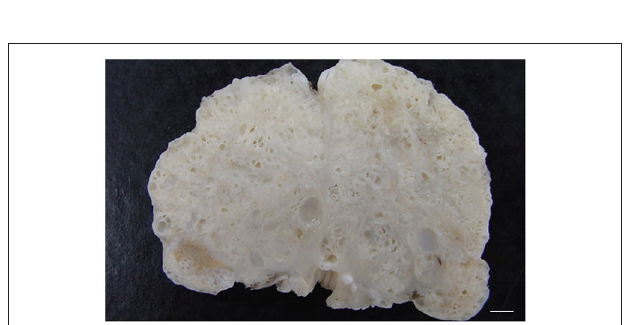
FIGURE 4 | Prostate aspirate showing a large cluster of uniform prostatic epithelial cells from a dog with prostatic hyperplasia. The cells have moderate amount of granular cytoplasm and round, central to eccentric nucleus with finely stippled to reticular chromatin. Note the pink granular material on the background, most likely indicating the secretory proteinaceous activity of the glandular epithelial cells. Prostate FNA, cytospin. Wright-Giemsa stain. Bar = 50 µ m.